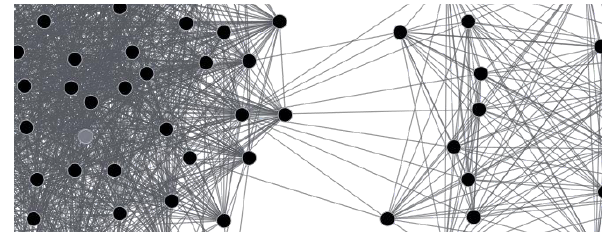
Figure 7 . "Social Network Diagram (segment)" by DarwinPeacock, Maklaan. Licensed under CC BY 3.0 via